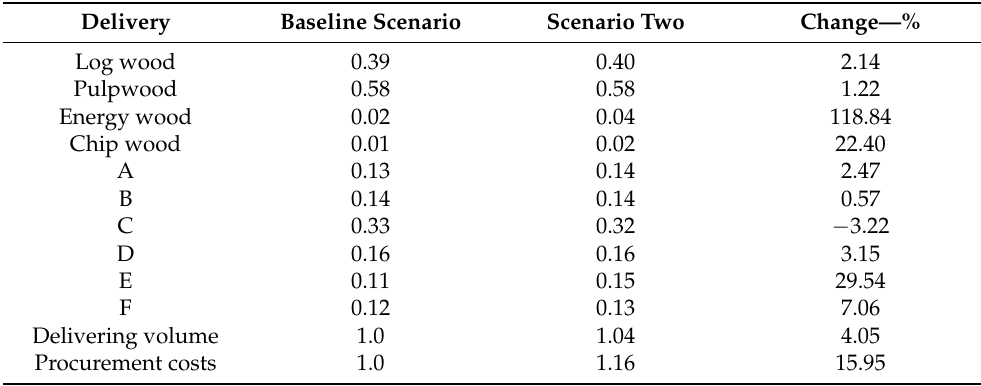
Table 2. Changes in wood deliveries and total costs of wood procurement regions (A–F) in scenario two, “energy reform”.